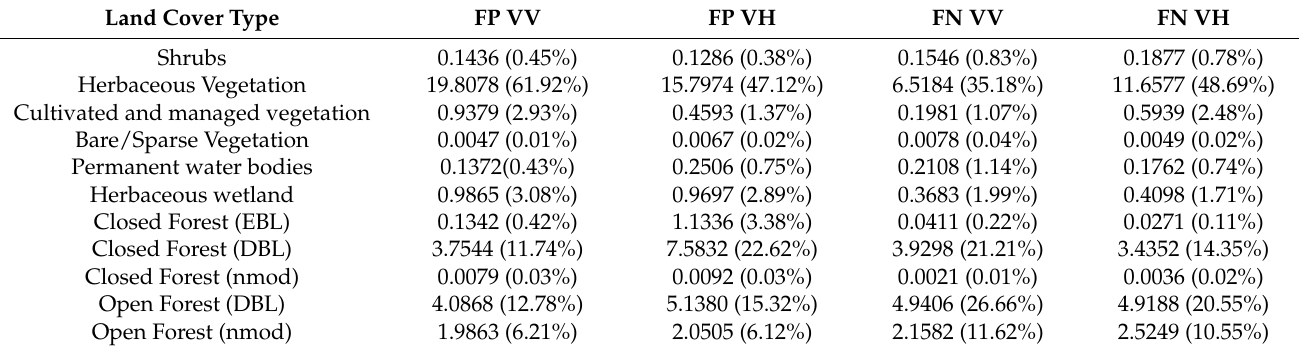
Table 4. L2 model error sources per Land Cover type (km 2 ).